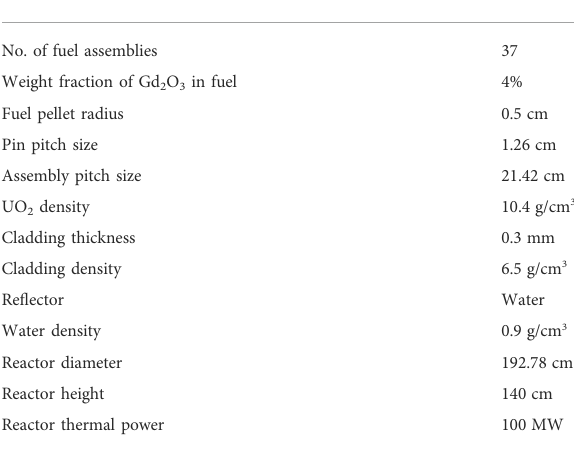
TABLE 1 Speci fi cations of the SMR